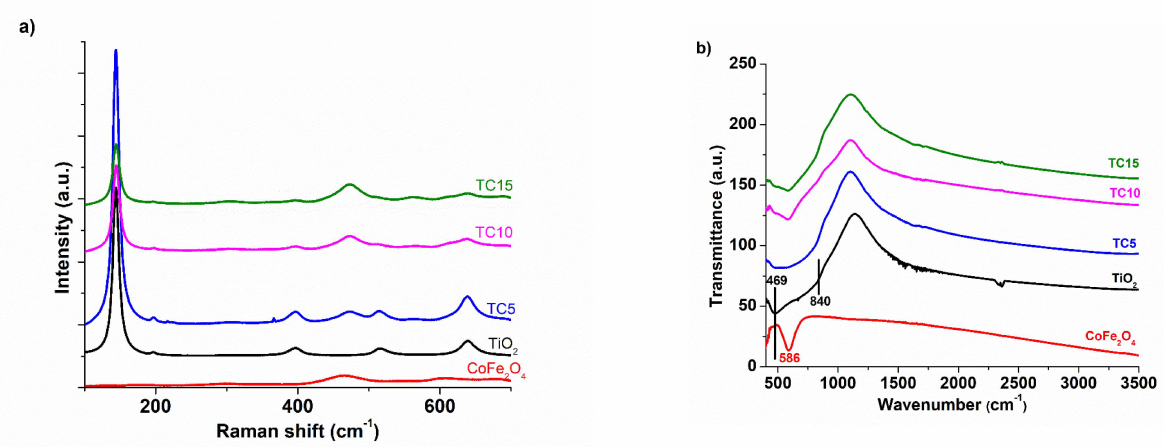
Figure 3. Vibrational spectrograms: ( a ) Micro-Raman and ( b ) FT-IR of synthesized